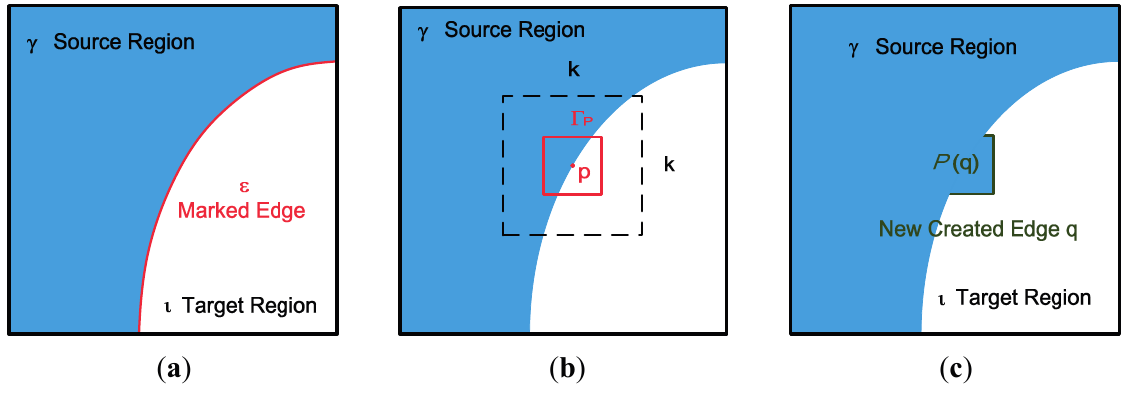
Figure 2. ( a ) Edge marking; ( b ) search range in the hole-padding process; ( c ) patch pasting in the hole-padding